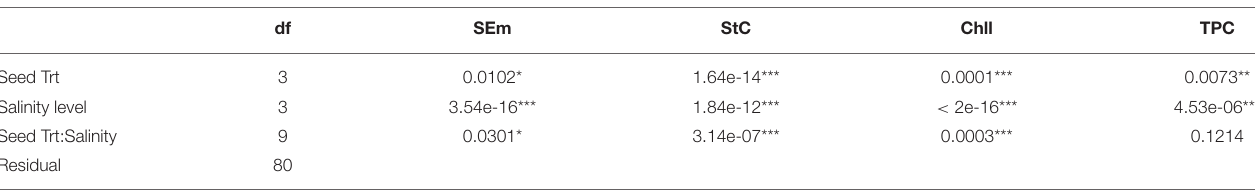
TABLE 3 | ANOVA table of physiological parameters measured from pot experiment. df SEm StC Chll TPC Seed Trt 3 0.0102* 1.64e-14*** 0.0001*** 0.0073**